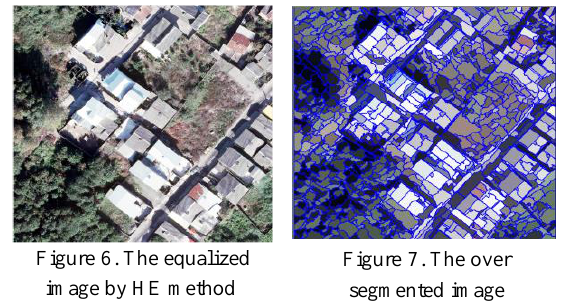
Figure 6. The equalized Figure 7. The over segmented